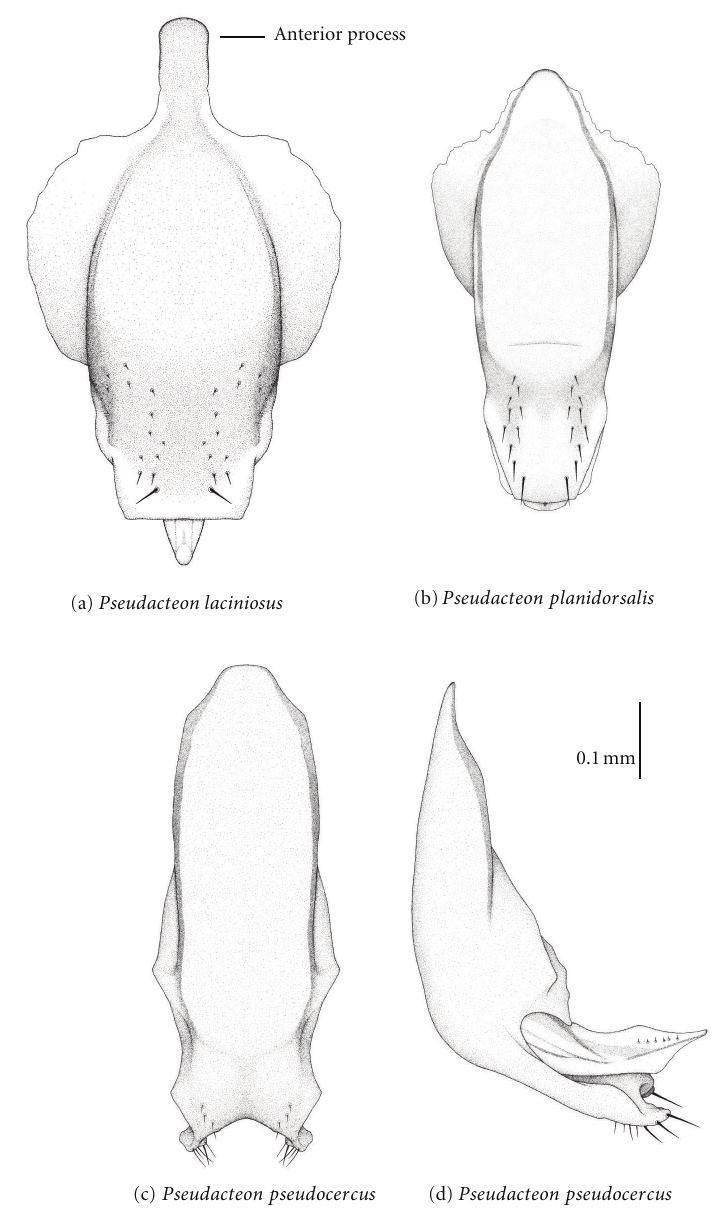
Figure 1: Pseudacteon species, female oviscapes, dorsal and right lateral (Figure